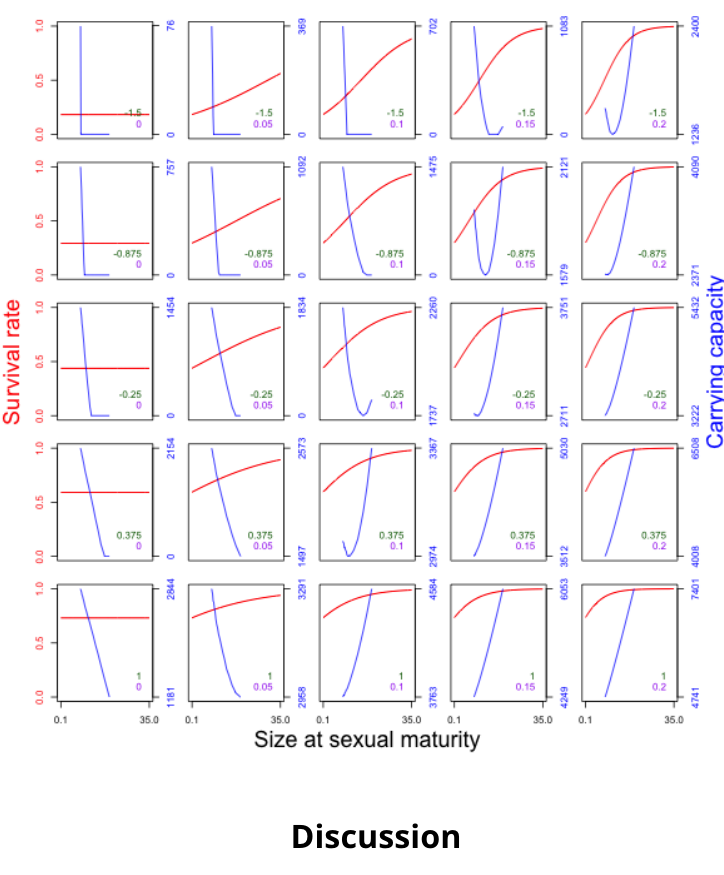
Figure 5. Figure 5. Dynamical consequences of altering the intercept and slope of the body size-survival function in the density-dependent reproduction scenario. As the elevation of the intercept (rows, and green numbers) and steepness of slope (columns and purple numbers) are altered, the change in the size-survival function alters selection on size at sexual maturity. The red lines represent the form of the size-survival function. The blue lines show how carrying capacity changes across the range of sizes of sexual maturity. The blue lines are analogous to Figure 2 for each parameterisation of the size-survival function but are drawn as continuous lines rather than as